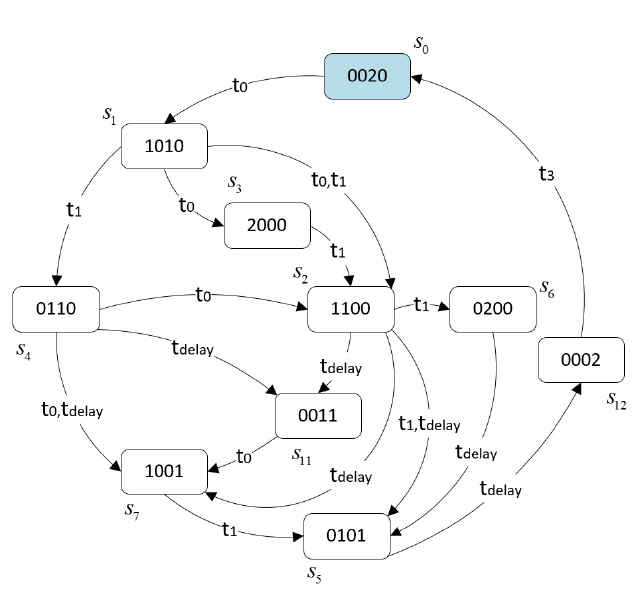
Figure 5. State-space (coverability tree) of the equivalent Petri net model illustrated in Figure 4, which shows all the markings that can be reached starting from an initial marking ( M 0 = [ p 0 p 1 p 2 p ] = [ 0 0 2 0 ] ) and subsequently firing a sequence of enabled transitions, using single-server